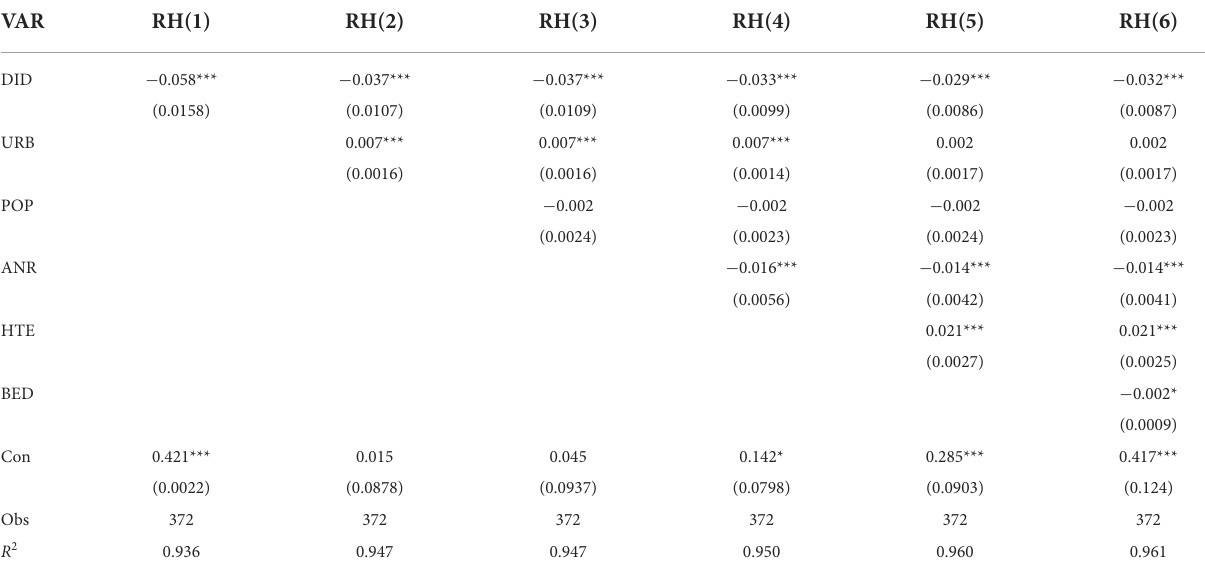
TABLE 4 DID regression